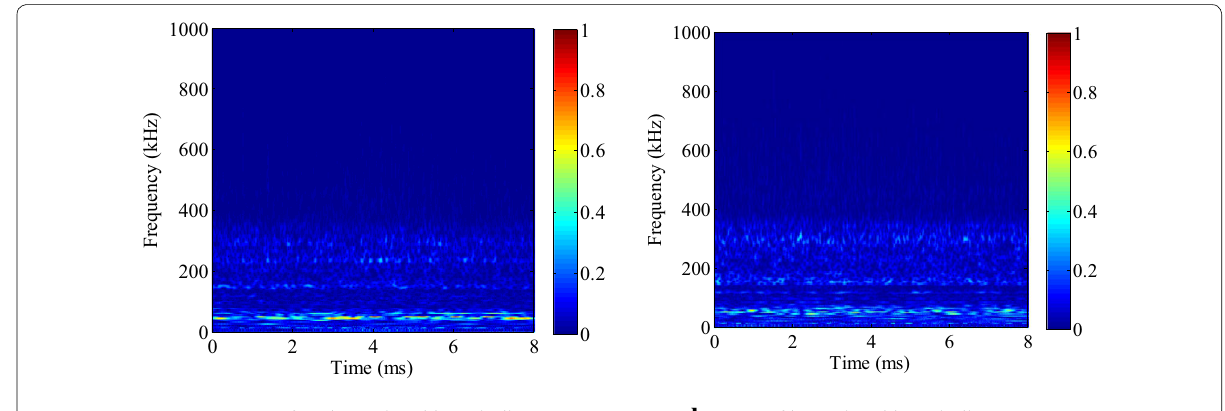
Figure 7 AE signals produced by grinding